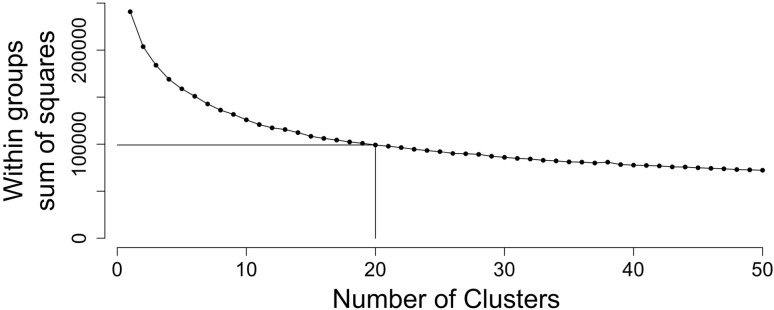
Twenty clusters capture majority of biological variation.The sum of squares within groups (WSS) was calculated to identify the optimal number of clusters using the ‘elbow method’. Based on this, we chose the number of clusters in Figure 3 to equal twenty where the addition of further clusters does not markedly reduce WSS.